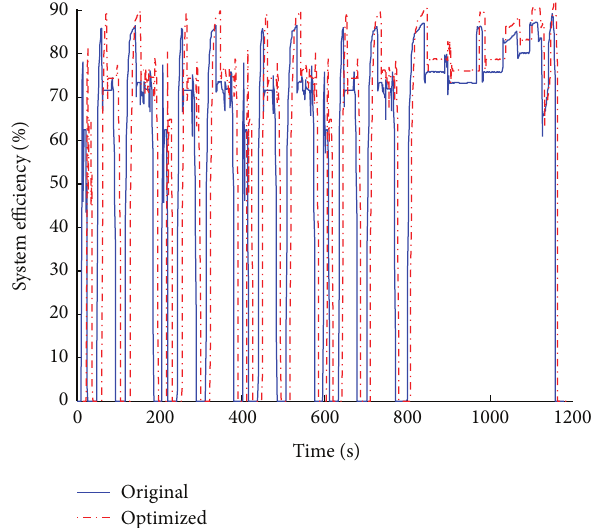
Figure 8: System efficiency curve on NEDC drive cycles.